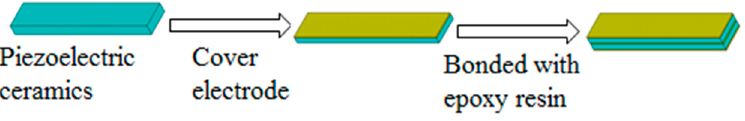
Figure 14. Preparation technology of the piezoelectric ceramic vibrator.